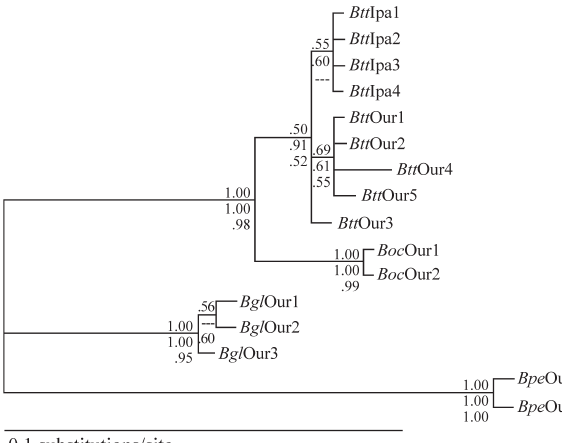
Figure 1 - Bayesian majority rule consensus phylogram for the Ourinhos- Ipauçu ITS2 data set. Values above nodes indicate clade posterior proba- bilities and those below refer to maximum parsimony (MP) and maximum likelihood(ML)bootstrapproportions,respectively(valueslowerthan.50 are not